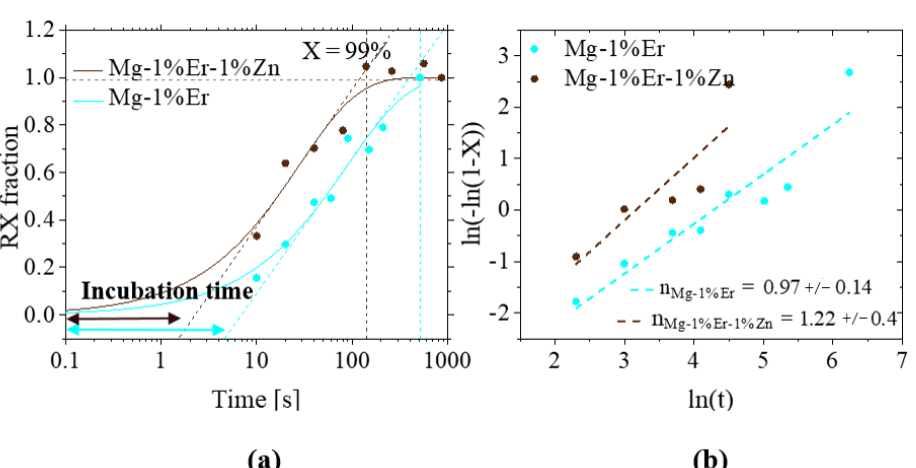
Figure 11. ( a ) Recrystallization kinetics of binary and ternary Mg-1%Er-(1%Zn) annealed at 350 ◦ C and the corresponding Avrami exponents ( b ).